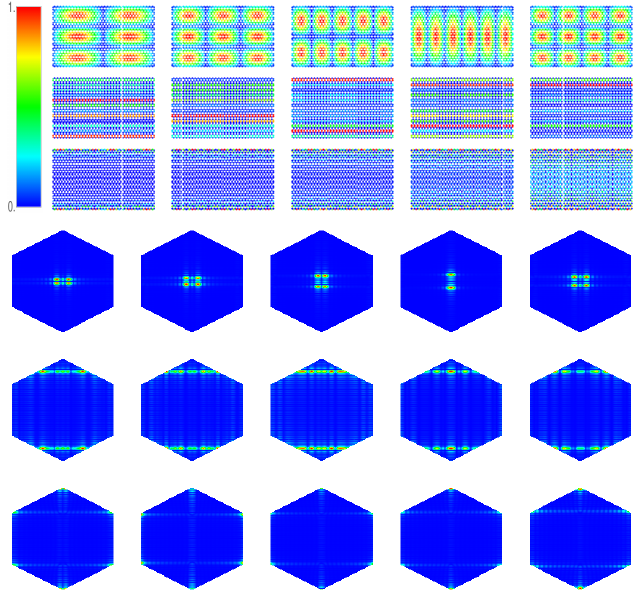
Figure 8. Hexagonal lattice with rectangular shape with 1656 sites (24 rows of 34 and 35 sites, respectively) and zigzag edges parallel to the longer sides. Squared wave functions (three upper rows) and momentum distributions (three lower rows) of states ν = 11 − 16 at the lower band edge (first and fourth row, respectively), of ν = 619 − 623 around the lower van Hove singularity vHs − at ν (cid:39) 619 (second and fifth row, respectively) and of states ν = 824 − 828 around the DP at ν = 828 (third and sixth row,